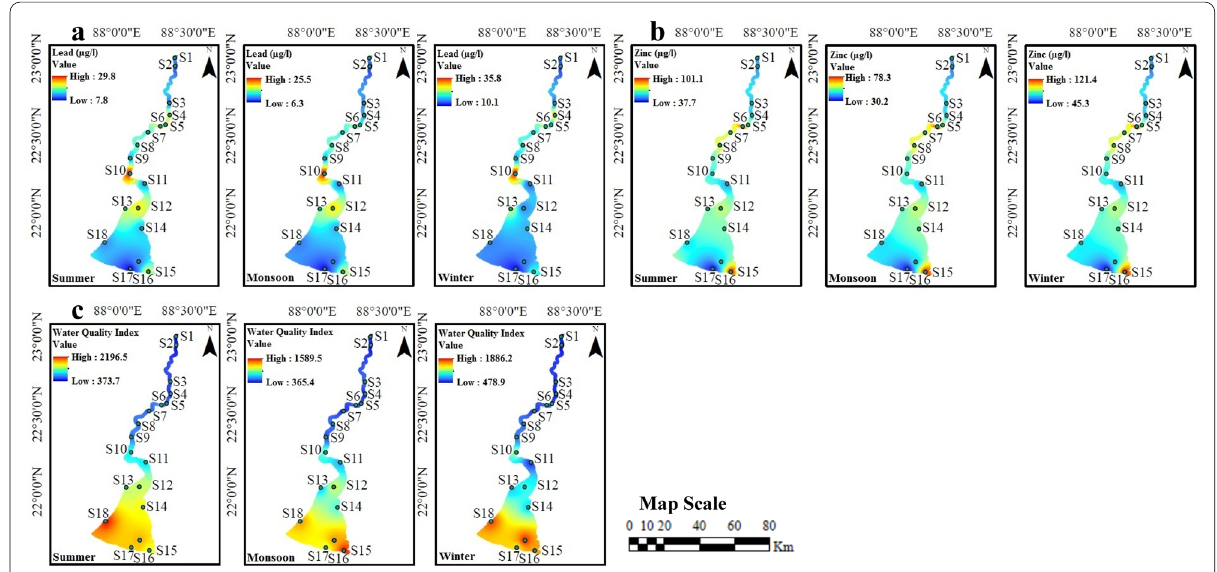
Fig. 4 Geospatial distribution of Lead (Pb), Zinc (Zn), and Water Quality Index (WQI) in river Hooghly. a Pb, b Zn, and c